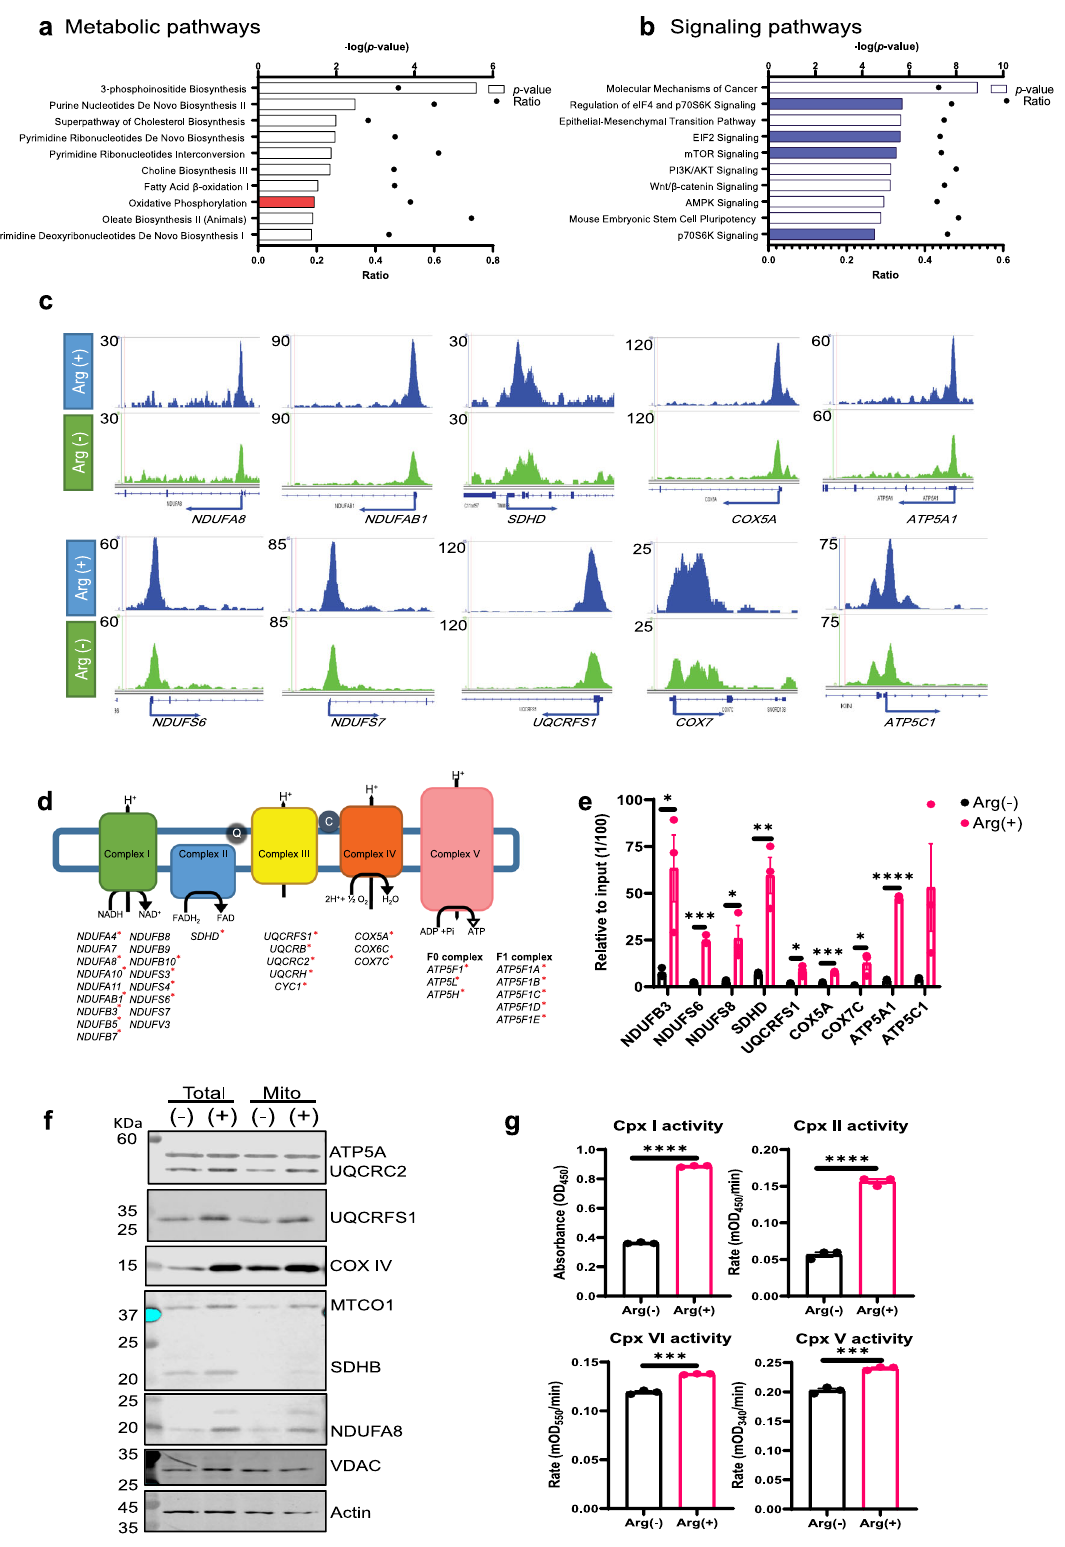
consistent with the annotation result. Strikingly, >46% (34/73) of the nuclear-encoded OXPHOS genes display heightened histone acetylation in the arginine-stimulation group, suggesting coordi- nated regulation by arginine (Fig. 2d). ChIP-qPCR (quantitative real-time polymerase chain reaction) of these genes validate the ChIP-seq results at OXPHOS genes (representative